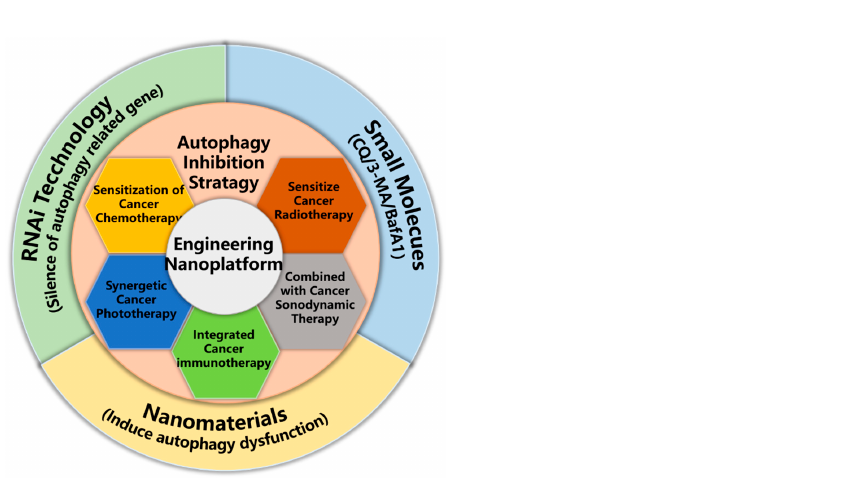
Table 1. Summary of combinatorial therapy based on nanotechnological platforms-mediated com- plementary autophagy inhibition. Autophagy Inhibition Mediated Nanoplatform Self-assemble nano-prodrug platform siBec1@PPN